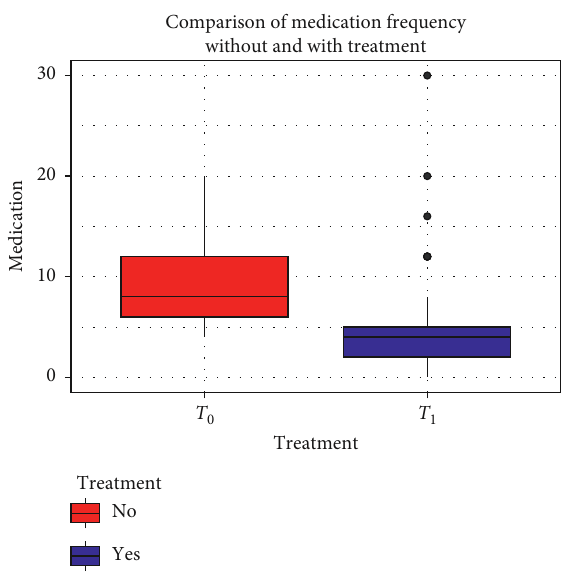
Figure 4: Comparison of monthly assumption of drugs for the attack before and after 12 weeks of treatment with umPEA.